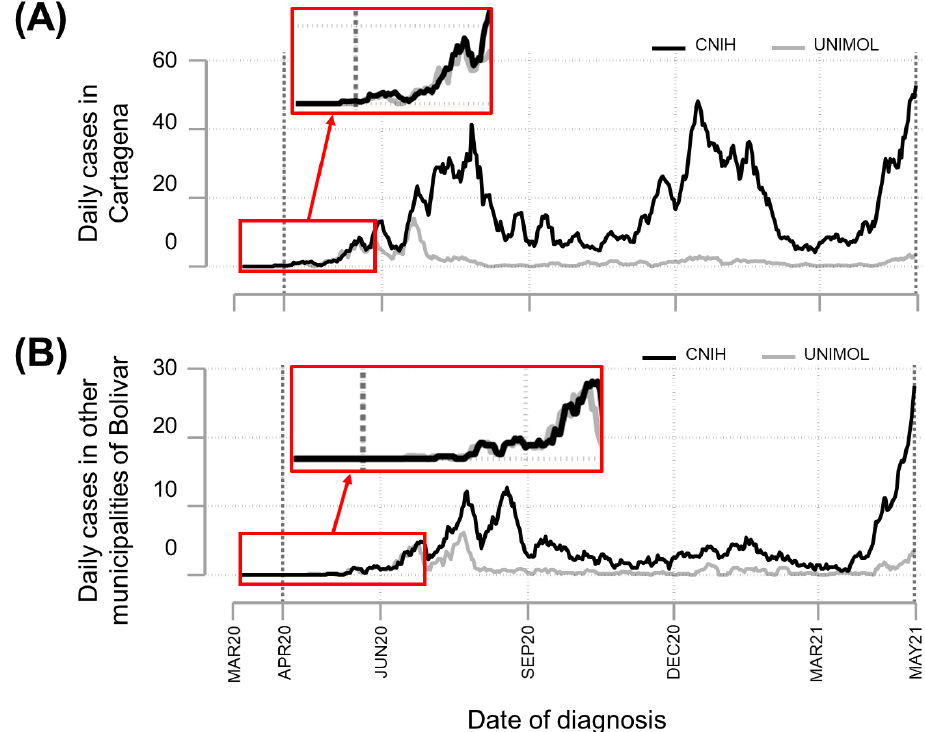
Figure 1. Comparison of epidemic curves based on data from two data sources, as of 31 April 2021. Daily new confirmed COVID-19 cases in Bolívar were used to build epidemic curves using 7-day moving averages. The curves were constructed using public information from the Colombian National Institute of Health (CNIH) and Unidad de Investigación molecular (UNIMOL) of the Universidad de Cartagena. Red boxes indicate the time frames for which the epidemic curves had a similar pattern; ~3 and ~4 months for Cartagena ( A ) and other Bolívar municipalities ( B ), respectively. The cumulative incidence of COVID-19 was comparable between males and females,